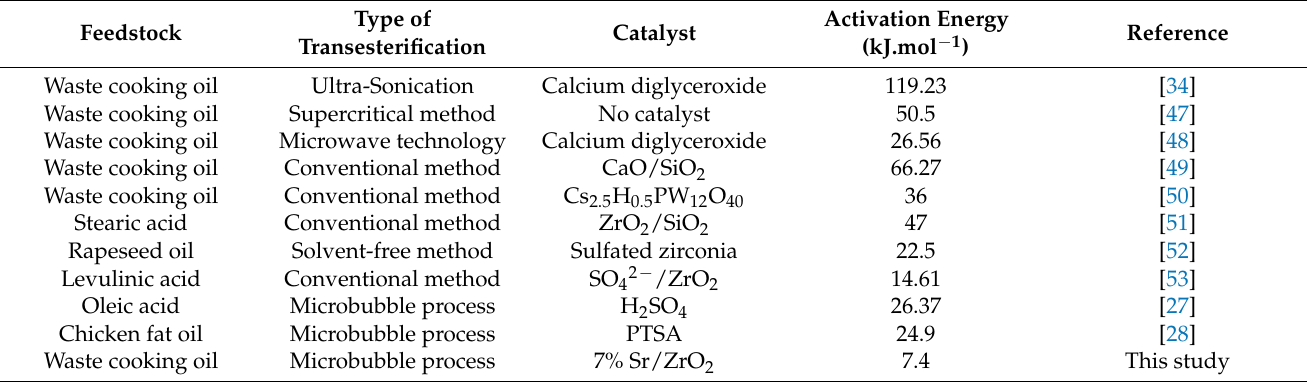
Table 4. The comparison of E A different biodiesel